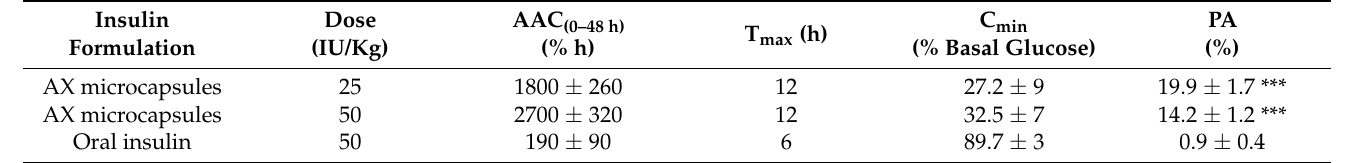
Table 2. Pharmacodynamic parameters after oral administration of insulin-loaded AX microcapsules in 25 and 50 IU/Kg or insulin solution (50